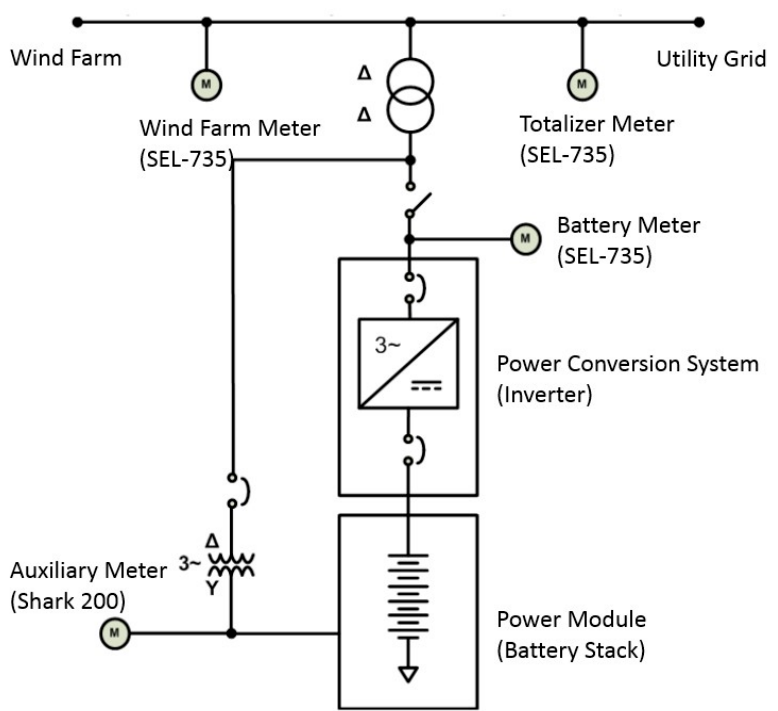
Figure 1. A simplified single line diagram of the Hawaii island battery energy storage systems (BESS) highlighting metering units.